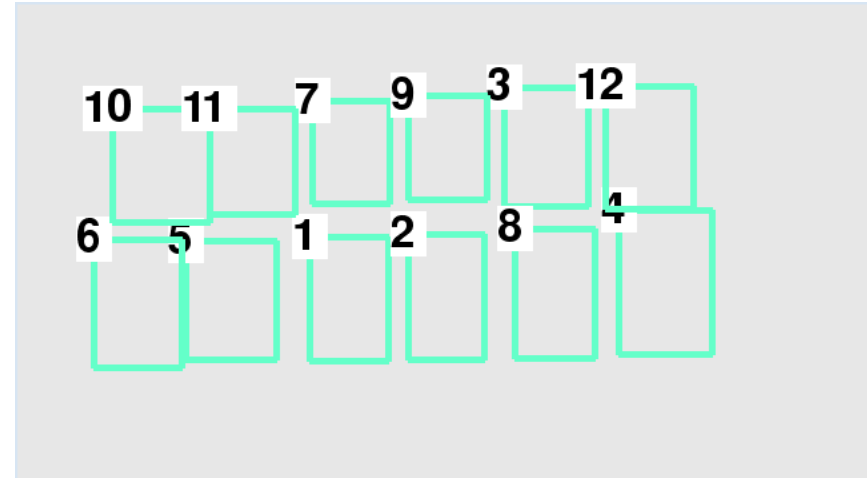
Figure 16. Random number of each parking space. Table 6. Position of the vehicles after sorting and the numbering of the parking spaces by the data layering method.